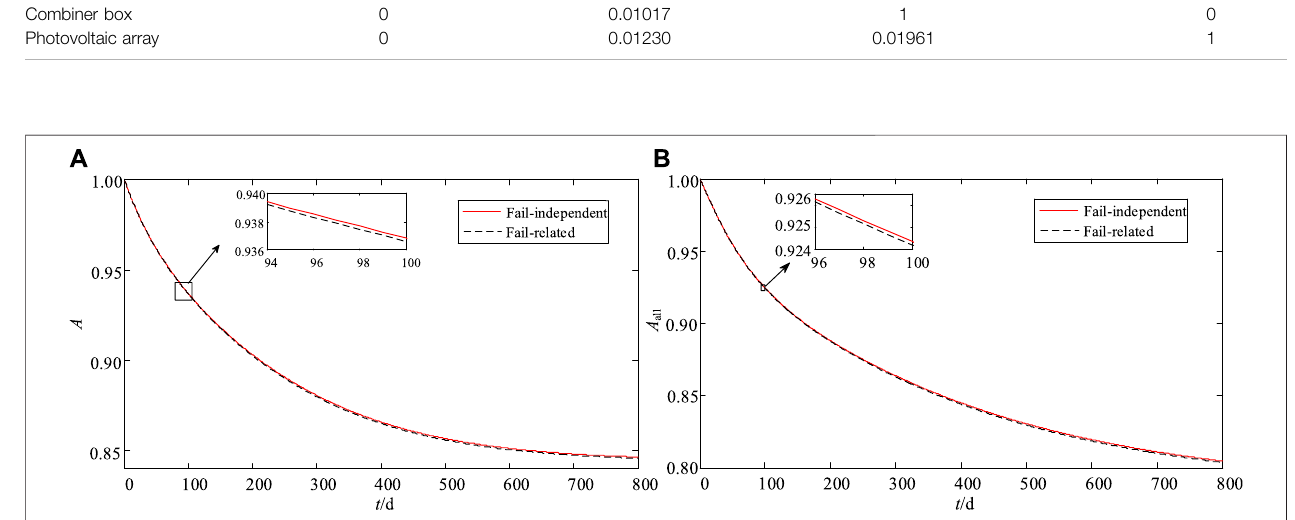
FIGURE 9 | Comparison curve of system availability. (A) Comparison curve of availability about H 2 . (B) Comparison curve of system availability.